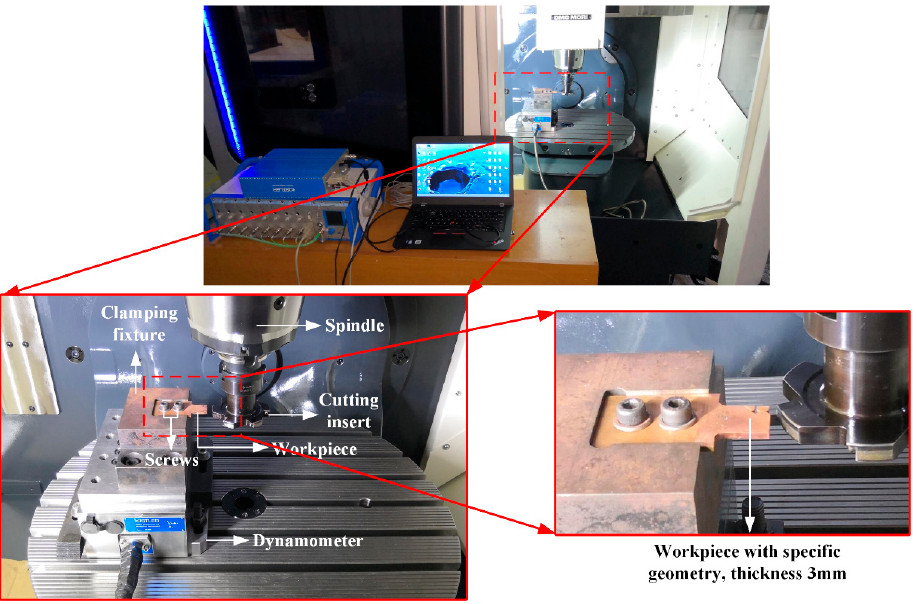
Figure 5. Experimental set-up on the milling machine and workpiece